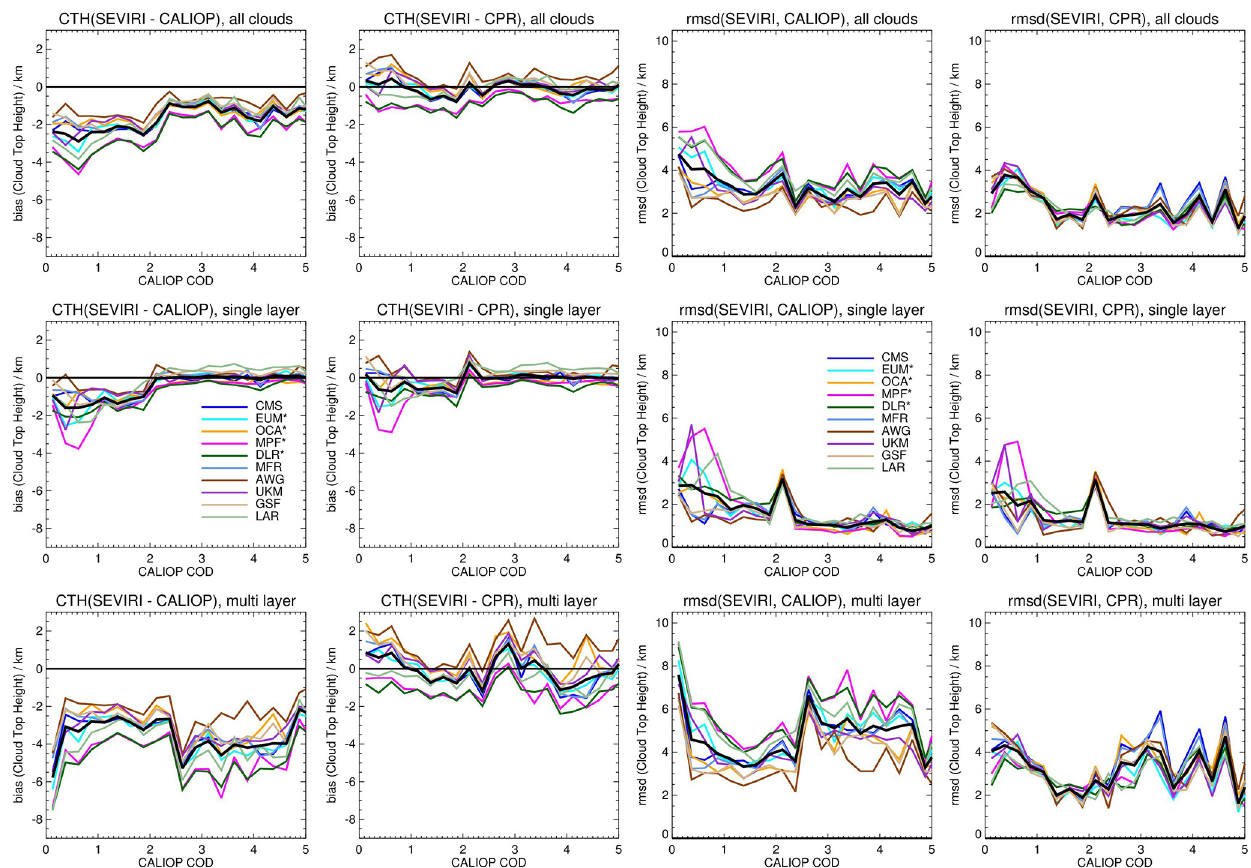
Figure 12. Differences and root mean square deviations (rmsd) of the CTH between the SEVIRI and CALIOP and CPR in dependence of the CALIOP column cloud optical depth for 13 June 2008, 12:00–15:30UTC. The uppermost row shows the results for all clouds, the second row for single layer and the third row for multi-layer clouds. The first and third columns show the comparison to CALIOP CTH, the second and fourth ones the comparison to CPR CTH. All statistics are calculated for the common